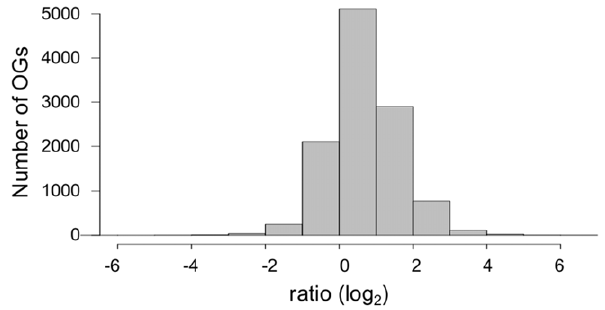
Figure 5. Ratio of soybean gene count to Arabidopsis gene count per OG. On average, the number of soybean genes per OG is 2- 3 times of Arabidopsis genes, but 300 OGs have far more soybean genes (more than 2-standard deviation from average), hence designat- ed as paralogue-rich OGs.